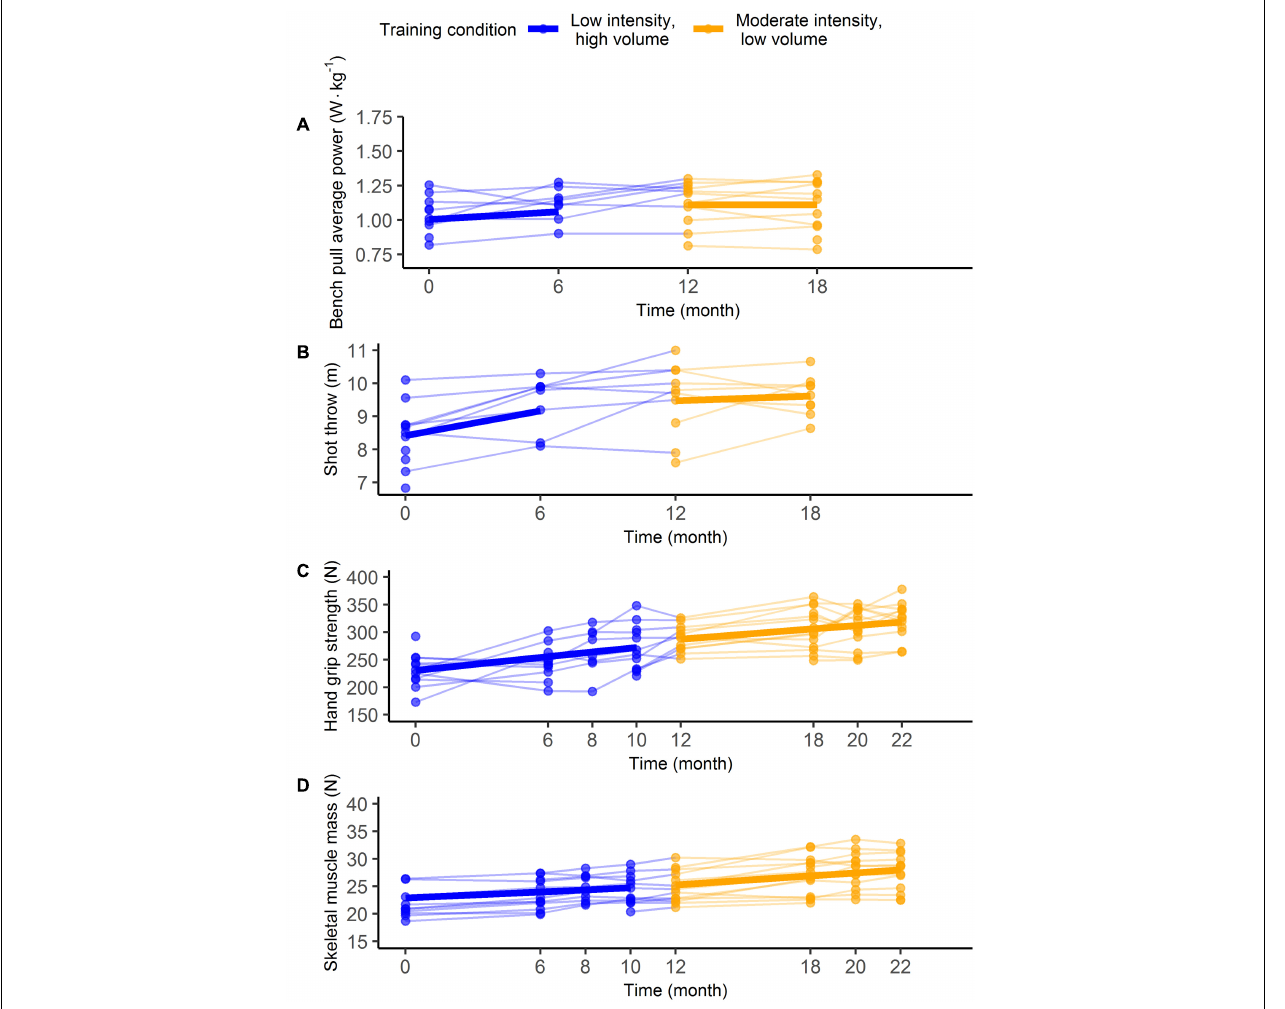
FIGURE 4 | Individual data (thin lines) and model estimates (thick lines) of the within-subject analyses for the outcomes bench pull average power (A) , shot throw (B) , hand grip strength (C) , and skeletal muscle mass (D)